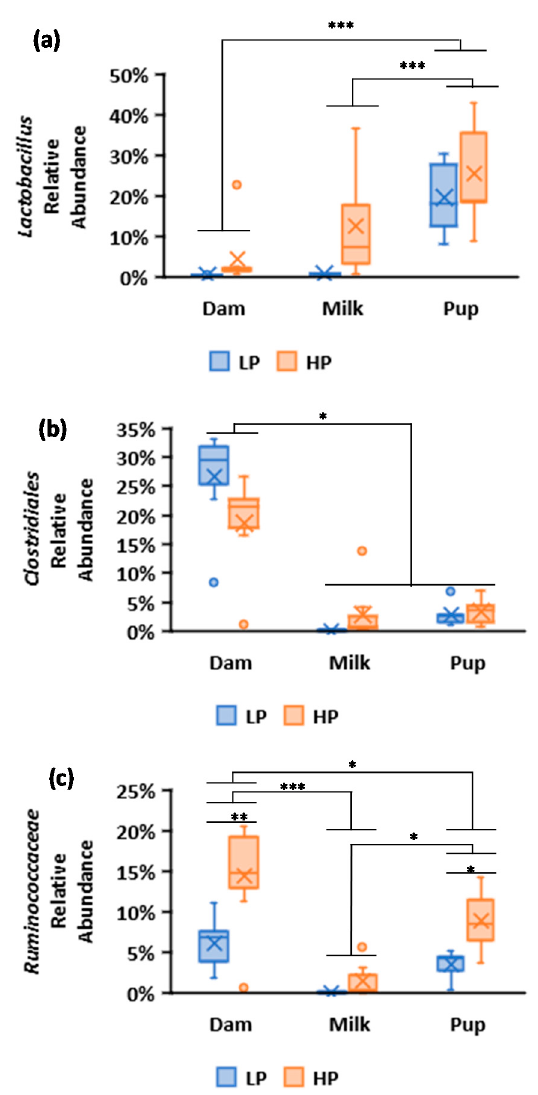
Figure 3. Box-and-whisker plots of relative abundances of OTUs affected by maternal dietary protein intake from rat dam cecum, milk, and pup cecum. Blue boxes denote 10% protein (LP), and orange boxes denote 20% protein (HP) with X’s denoting means. ( a ) Lactobacillus , ( b ) Clostridiales , ( c ) Ruminococcaceae (GLM, * p < 0.05; ** p ≤ 0.001; *** p ≤ 0.0001).